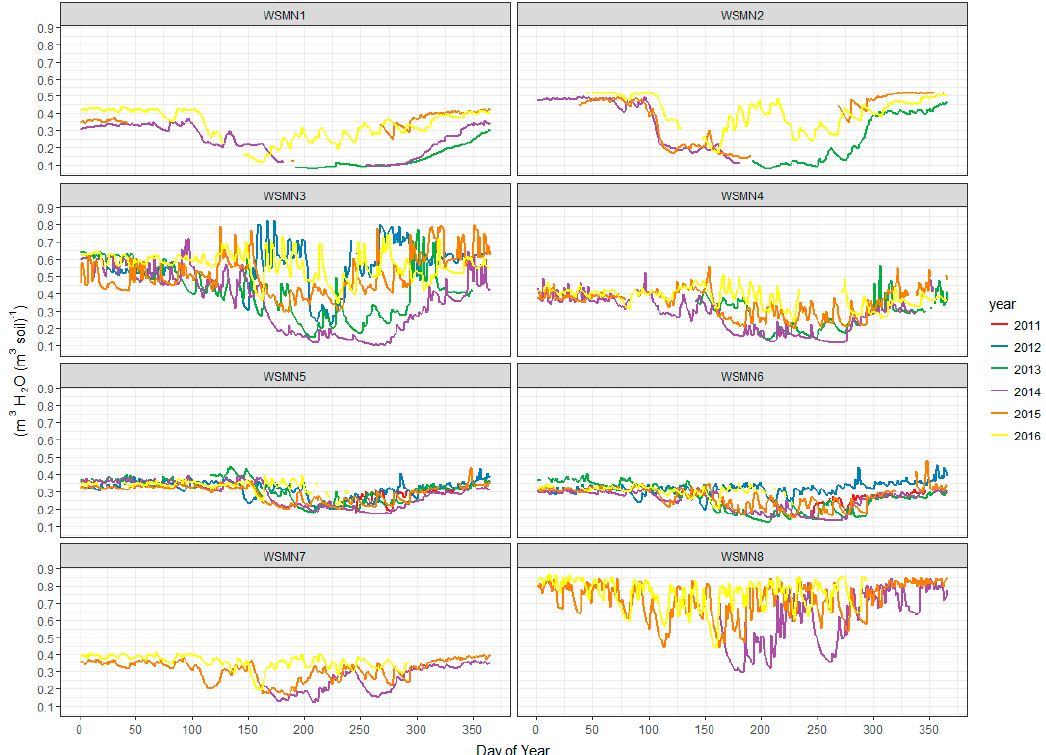
Figure 2. Time series of SSM at 5 cm depth from the soil surface layer measured at the WSMN experimental sites from their individual installation dates to the present.